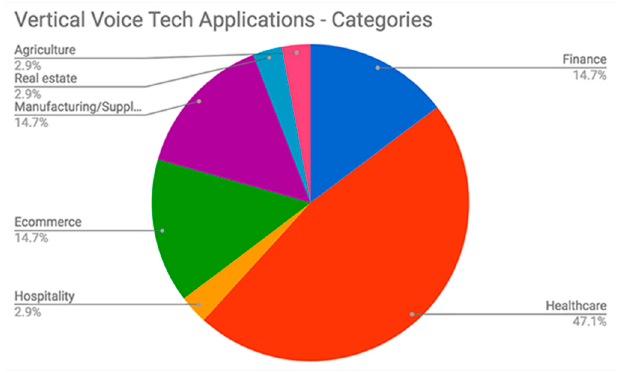
Figure 1. Vertical applications in voice tech [15].